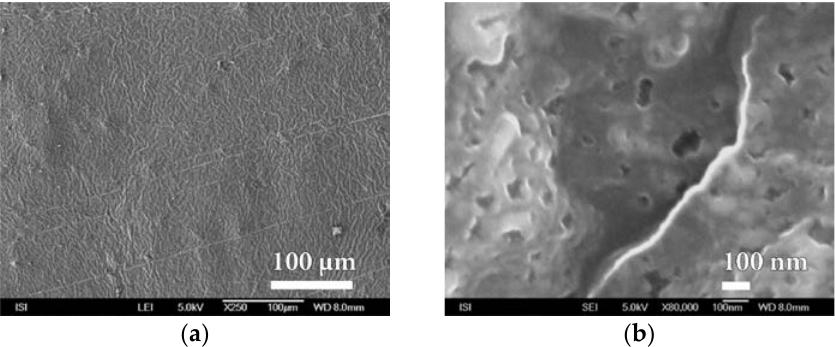
Figure 15. SEM micrographs of surface SiO x barrier nanocoating prepared by plasma deposition by HMDSO method on the Viton fluorelastomer at magnification of ( a ) 250× and ( b ) 80,000×.